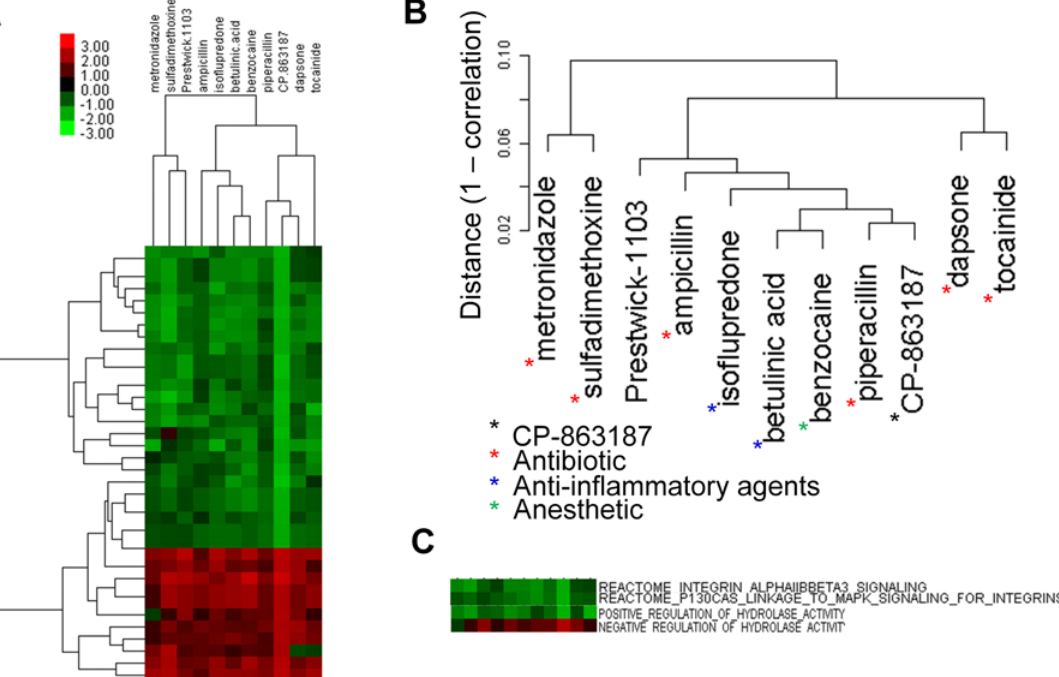
Fig 8. GSLHC identifies CP-863187 as a potential antibiotic. (A) A correlation > 0.9 sub-heatmap including the compound CP-863187 of unknown function from a GSLHC-generated heatmap based on the ES of 36 tags significantly enriched in CP-863187 with permutation p < 0.005. (B) Detail of the drug cluster associated with the sub-heatmap. According to TTD database, piperacillin, dapsone, tocainide, ampicillin, sulfadimethoxine, metronidazole (red asterisk) are antibiotics, betulinic acid and isoflupredone (blue asterisk) are anti-inflammatory agents, and benzocaine (green asterisk) is an anesthetic. (C) Detail of the tag cluster with the sub-heatmap shows functions known to block the formation of bacteria cell wall by inhibition of integrin signaling pathway.